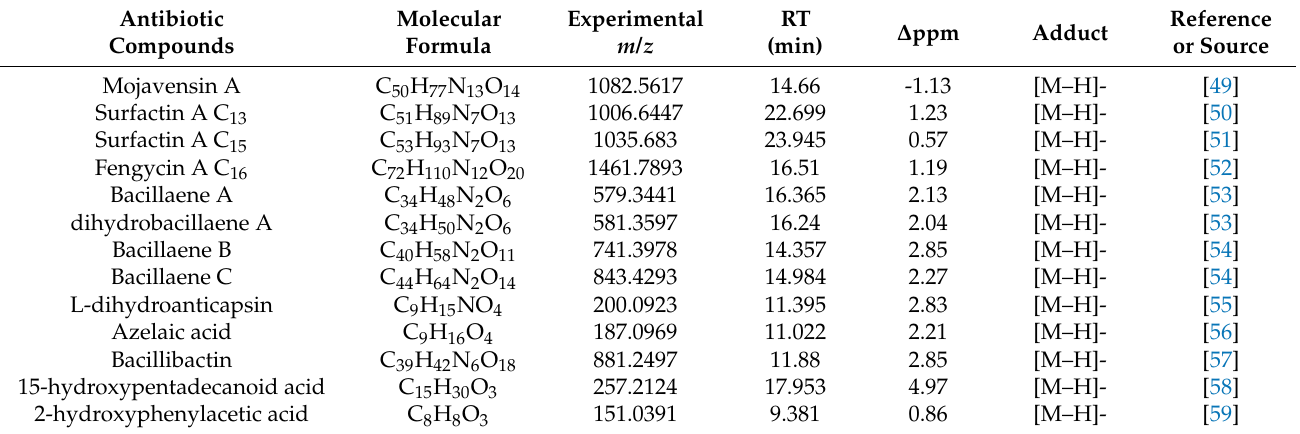
Table 3. Secondary metabolites biosynthesized by B. halotolerans Cal.l.30 and putatively annotated through UHPLC-HRMS